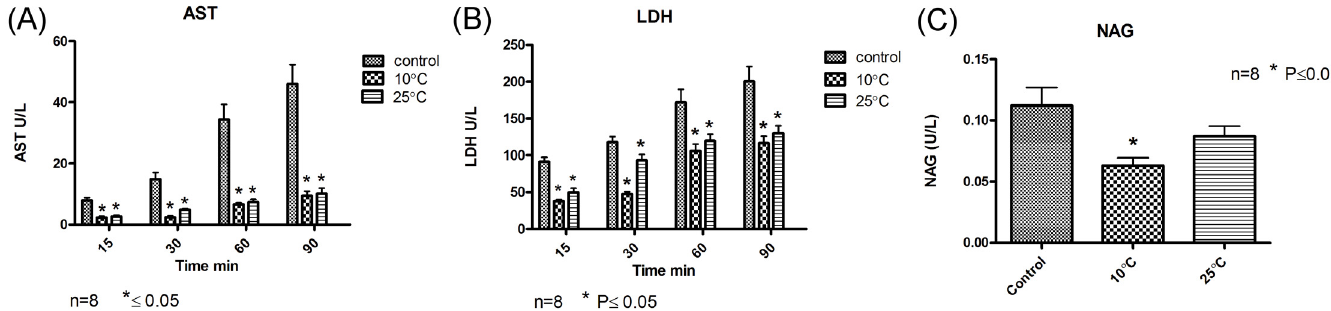
Fig 3. Panel A Perfusate level of AST during 90 minutes of perfusion in the control and gradual rewarming groups. Panel B Perfusate level of LDH during 90 minutes of perfusion. Panel C The level of NAG in the ultrafiltrate during perfusion in the control and gradual rewarming groups. * P < 0.05 vs control group. Values are mean ± standard